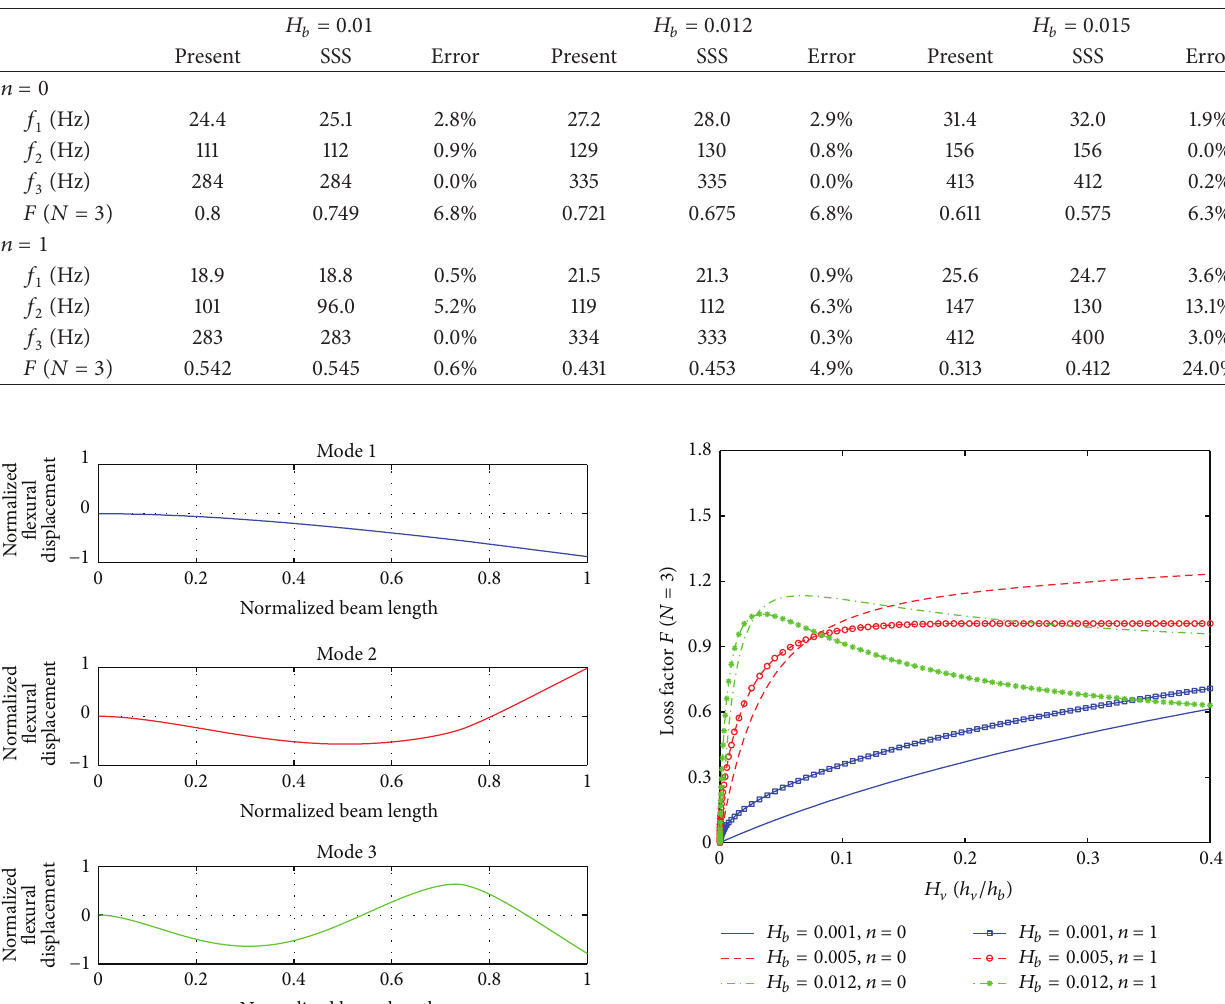
Table3:ComparisonbetweenpresentmodelandSSSmodelonfrequenciesandlossfactorsforvariousvaluesof 𝐻 𝑏 and 𝑛 ( 𝐻 𝑏 = 𝐻 𝑐 , 𝐻 V = 0.4 , 𝑋